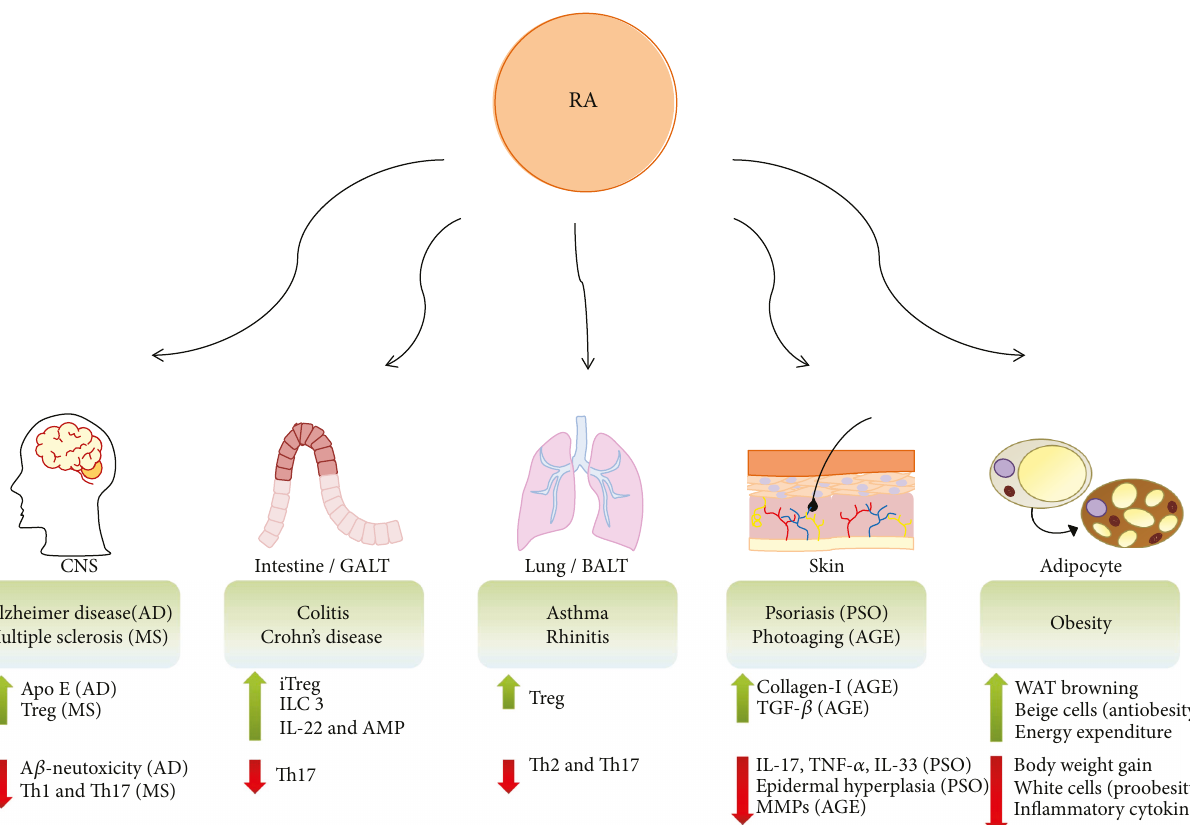
Figure 3: Potential anti-in fl ammatory e ff ects of RA. RA can decrease in fl ammatory processes, promoting homeostasis and attenuating harmful in fl ammatory responses in mucosa and tissues. RA shows immunosuppressive e ff ect on Th1/Th17 cells in multiple sclerosis (MS) and induces Apo E in microglia, protecting from the neurotoxic e ff ects mediated by amyloid β (A β ) in Alzheimer disease (AD), contributing to neuronal homeostasis. RA is crucial for intestinal tolerance, by inducing Treg, cytokines IL-10 and IL-22, and antimicrobial peptide (AMP) synthesis, which may lead to Th17 inhibition. RA modulates in fl ammatory airway diseases (asthma and rhinitis) by inhibiting Th2/Th17 response and enhancing Treg cells. Retinoids increases type I collagen and TGF- β , reducing matrix metalloproteinase (MMPs) in photoaging (AGE), and reduces IL-1 family cytokines (IL-17 and TNF- α ), IL-33, and epidermal hyperplasia in psoriatic (PSO) lesions. RA also has e ff ects in adipocytes, promoting white adipose tissue (WAT) browning by di ff erentiation into beige cells (antiobesity) instead of white cells (proobesity). The formation of brown adipocytes within WAT enhances energy expenditure and reduces obesity. In addition, RA can repress the expression of in fl ammatory chemokines and cytokines, inhibiting in fl ammatory responses triggered by